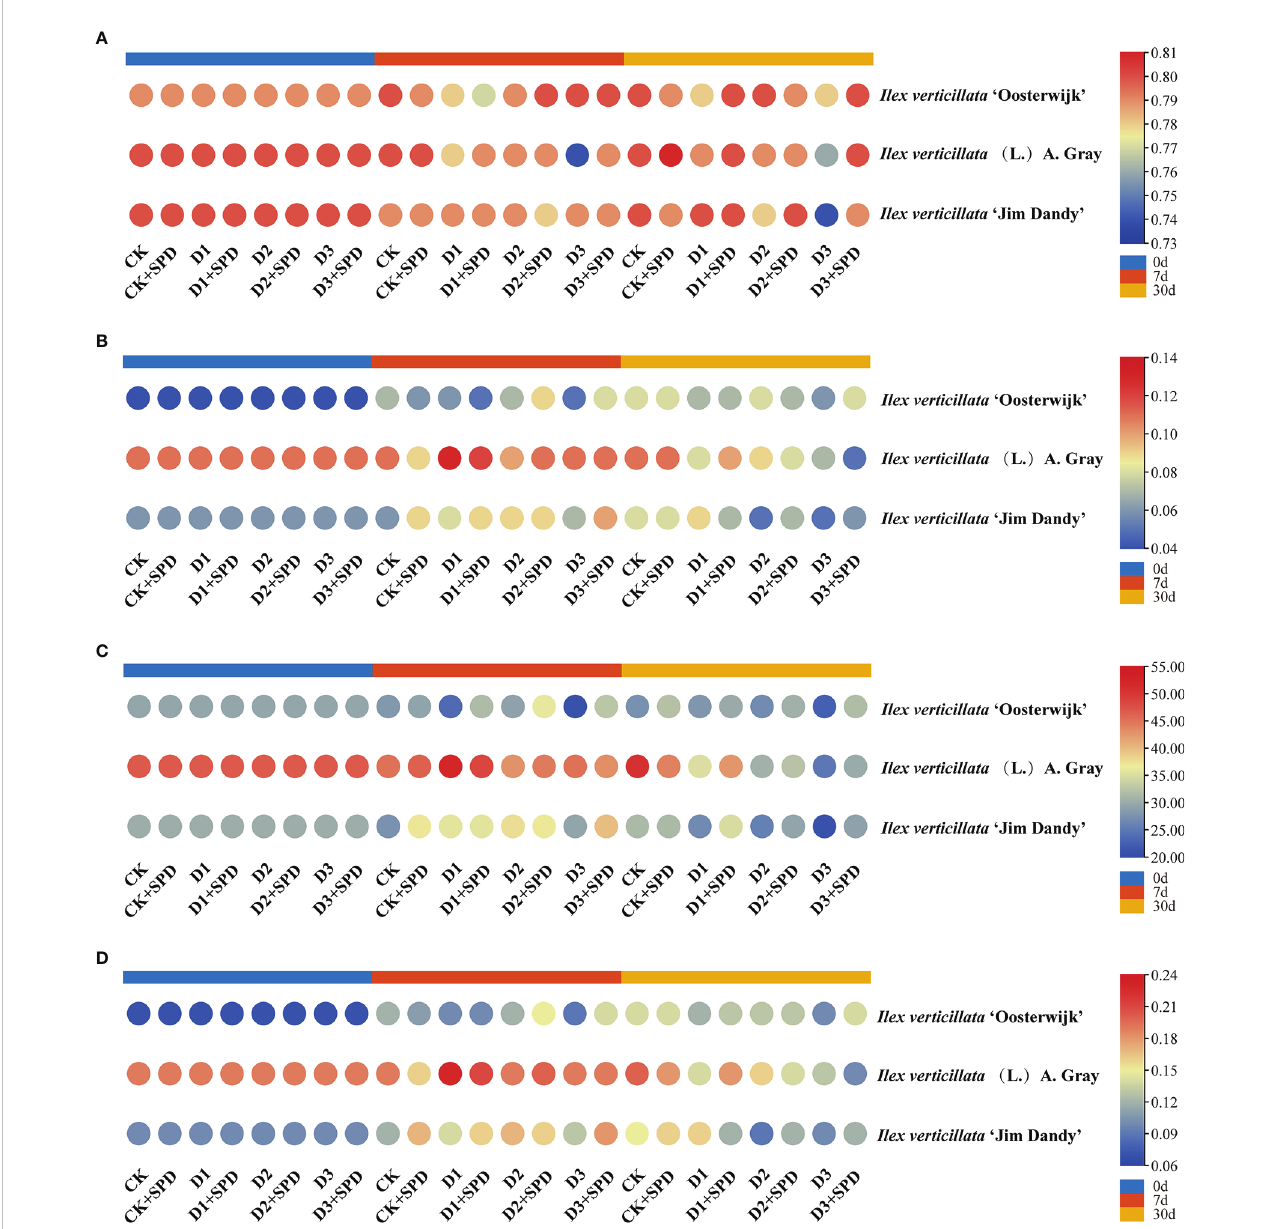
FIGURE 4 The changes of chlorophyll fl uorescence parameters in Ilex verticillata leaves under drought and spermidine treatment. (A) Fv/Fm; (B) Y(II); (C) ETR; (D) qP. Data were shown in different heatmaps, where red indicates high values and blue indicates low values. CK, control; CK+SPD, control with spermidine; D1, mild drought; D1+SPD, mild drought with spermidine; D2, moderate drought; D2+SPD, moderate drought with spermidine; D3, severe drought; D3+SPD, severe drought with